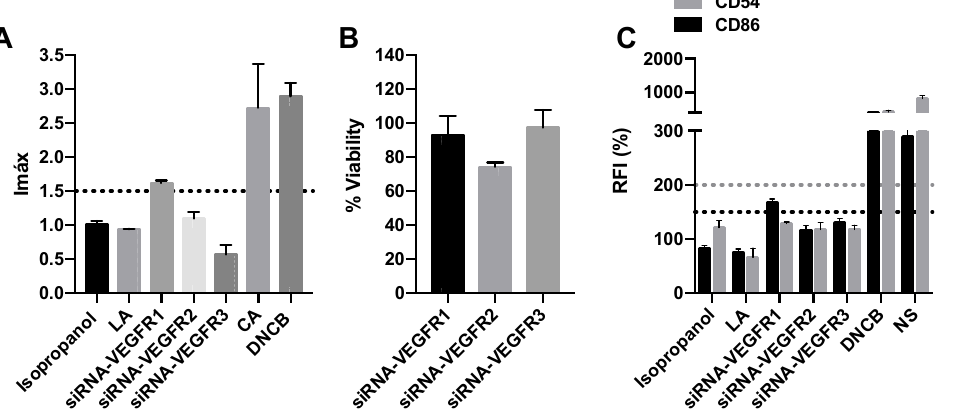
Figure 6. siRNA-VEGF1 mediates delayed-type hypersensitivity. ( A ) Representation of luciferase activity (Imáx) after 48 h of incubation with siRNA-VEGF1, siRNA-VEGF2, and siRNA-VEGF3. ( B ) % of viability after 48 h of incubation with siRNA-VEGF1, siRNA-VEGF2, and siRNA-VEGF3. ( C ) Representation of relative fluorescence intensities of CD86 and CD54 after 48 h of incubation with siRNA-VEGF1, siRNA-VEGF2, and siRNA-VEGF3. Lactic acid (LA) and isopropanol were used as negative controls. 1-chloro-2,4-dinitrobenzene (DNCB), cinnamic aldehyde (CA), and nickel sulfate (NS) were used as positive controls. Shown are mean ± SEM ( n = 3). The dashed line depicts the minimum positive stimulation index.